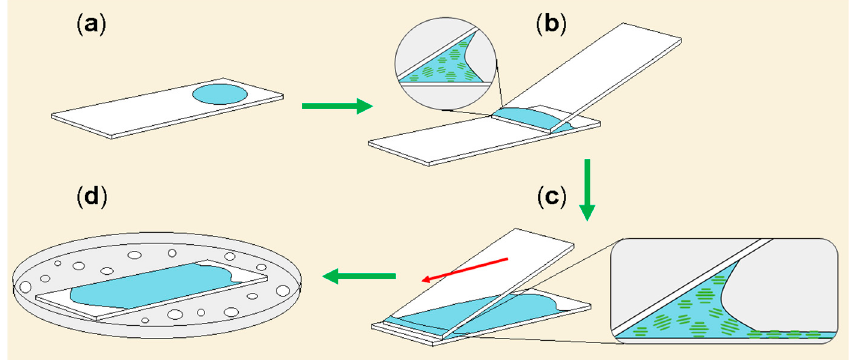
Figure 1. Schematics of the preparation method: ( a ) a drop of cellulose nanocrystal (CNC) suspension is deposited onto a glass substrate; ( b ) another glass slide is placed so that the suspension adheres to it; ( c ) the coater plate is moved to distribute the suspension; ( d ) the sample is placed inside a petri dish for the slow evaporation of water in a humid environment.